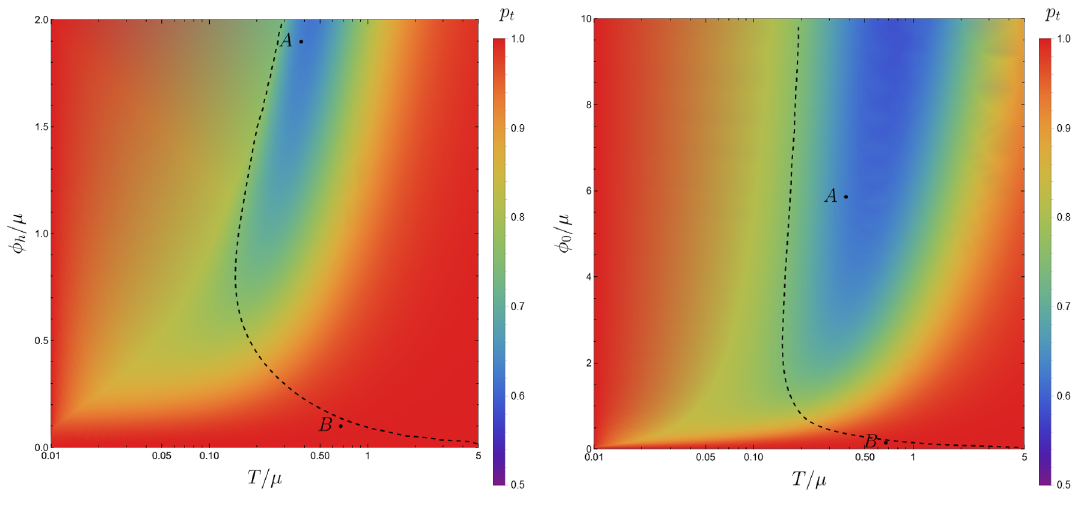
Figure 4 . Kasner exponent p t for the neutral scalar case ( q = 0 ). Left: p t as a function of T/µ and φ h /µ . Right: p t as a function of T/µ and φ 0 /µ . Here we have p t > 0 and α > 1 in all the parameter space, and so there is no Kasner inversion. The points marked with letters A and B correspond to the specific examples shown in figure